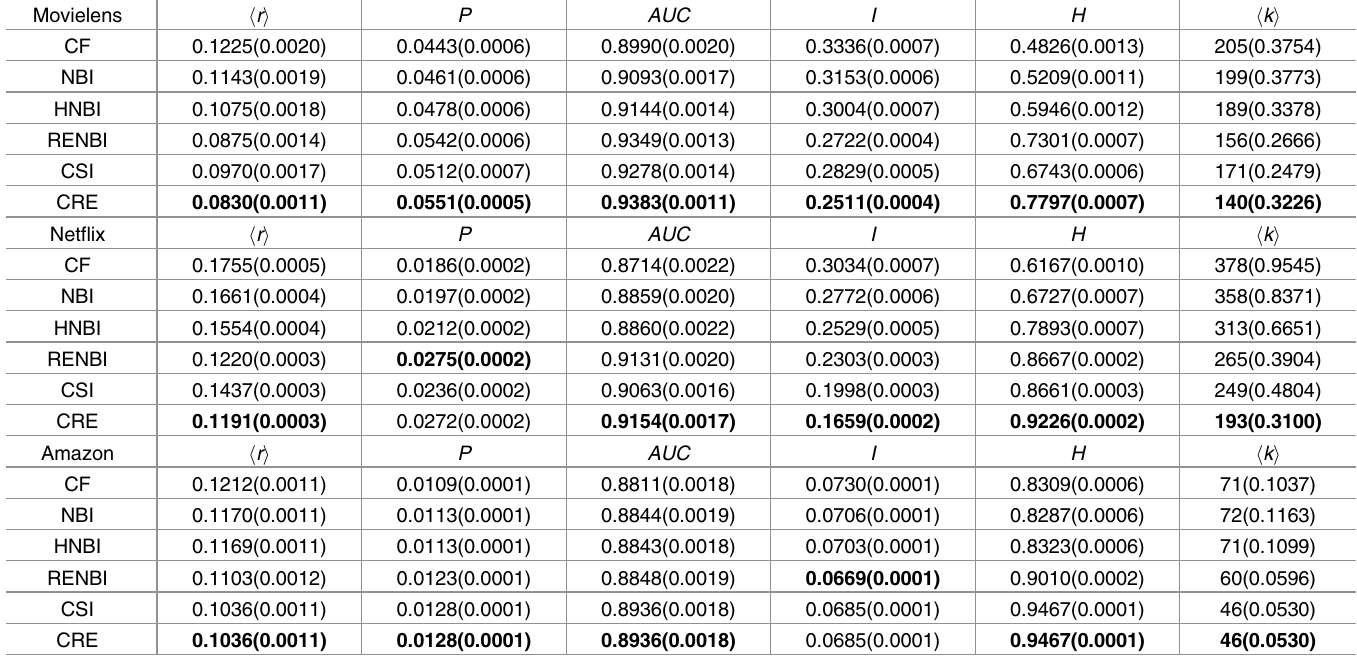
Table 2. Performancecomparison table. The optimal α ’s of ranking score h r i for HNBI, RENBI, CRE are (-0.86, -0.76, -0.93) in Movielens, (-1, -0.81, -0.88) in Netflix and (-0.08, -0.53, 0) in Amazon, respectively. And other evaluationmetrics— P for precision, AUC, I for intra-similarity, H for hammingdistance, h k i for popularity—take the values corresponding to the optimal α of h r i . The recommendation list L = 100, and the samplingnumber n in AUC is one million. All the values are obtainedby averagingover ten independent runs with different data set divisionsand numbersin brackets stand for the standard